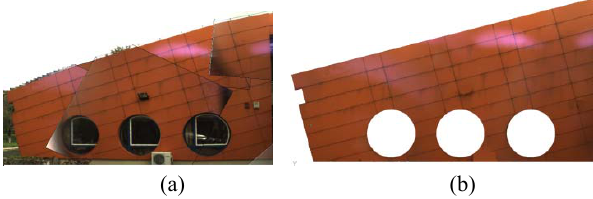
Figure 11. A plan that is part of the front façade of the building (a) The digital image (b) The surface textured by using the presented